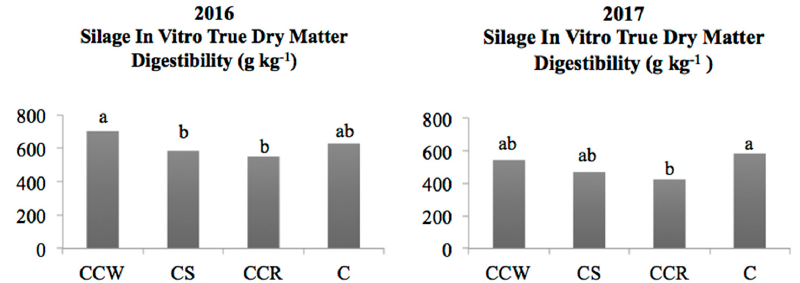
Figure 4. In vitro true dry matter digestibility differences ( p < 0.05) of silage for corn grown as a monoculture (C), or grown interseeded with cowpea (CCW), sunn hemp (CS) or crabgrass (CCR). Means within a column for each corn agronomic characteristic without a common superscript differs ( p < 0.05) .